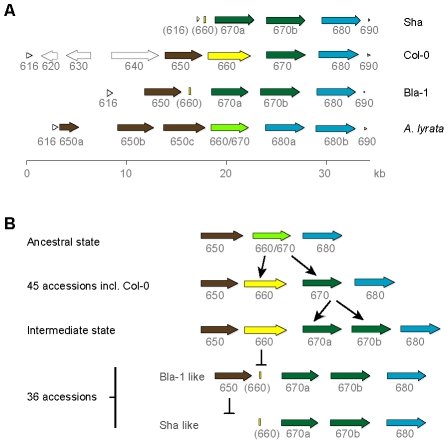
OAK kinase cluster architecture.(a) Last three digits of At5g59XXX gene identifier given. Truncated genes are indicated by brackets around the gene identifier. CACTA transposons and the pseudogene in Col-0 are indicated by light grey, unfilled arrows. (b) Hypothesized events in the evolution of the OAK kinase cluster in Bla-1 and Sha.